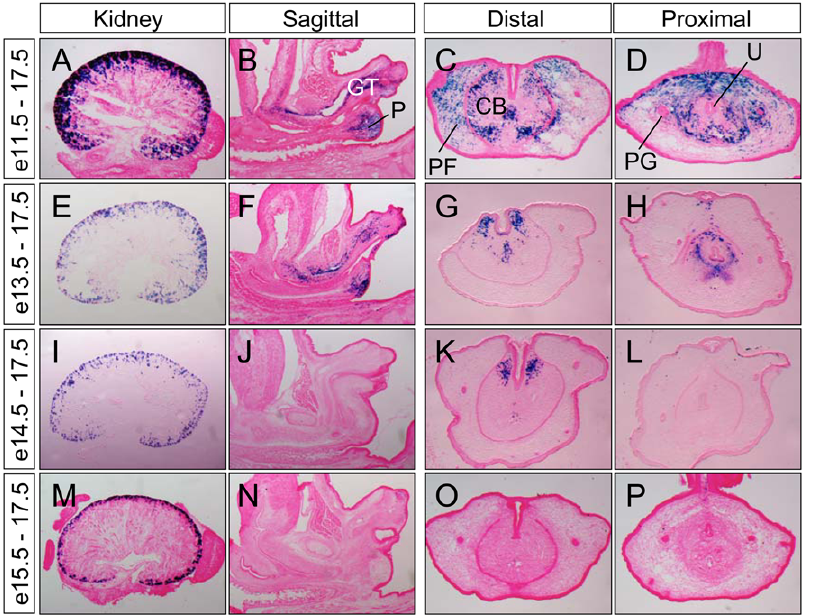
Figure 3. An inducible genetic fate map of Six2- expressing PCM progenitors. Double Six2 GCE/ + ; R26R LacZ pregnant females were treated with a single dose of tamoxifen at e11.5, e13.5, e14.5 and e15.5, and all embryos were collected and analyzed at e17.5 with X-gal staining (blue). ( A , E , I and M ) kidney sections; ( B–D , F–H , J–L and N–P ) urogenital sections. CB, prospective corporal body; GT, genital tubercle; P, perineum; PF, preputial fold; PG, preputial gland; U,